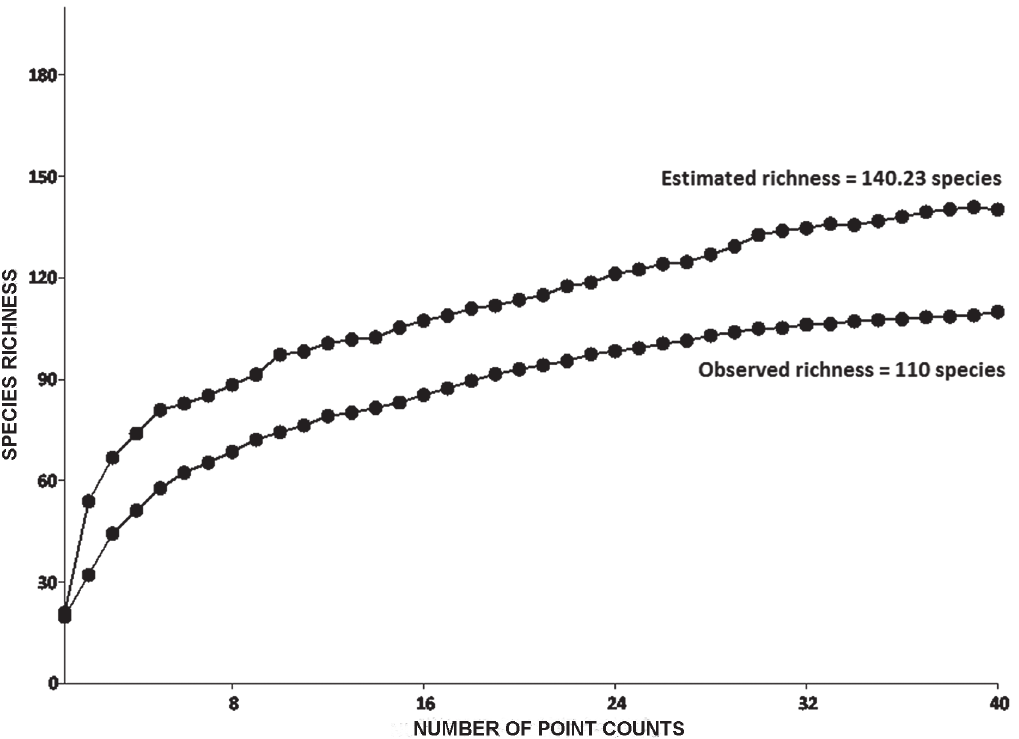
Figure 2 - Collector curve with the observed and estimated bird species richness along the vegetation gradient in Maciço do Urucum, western